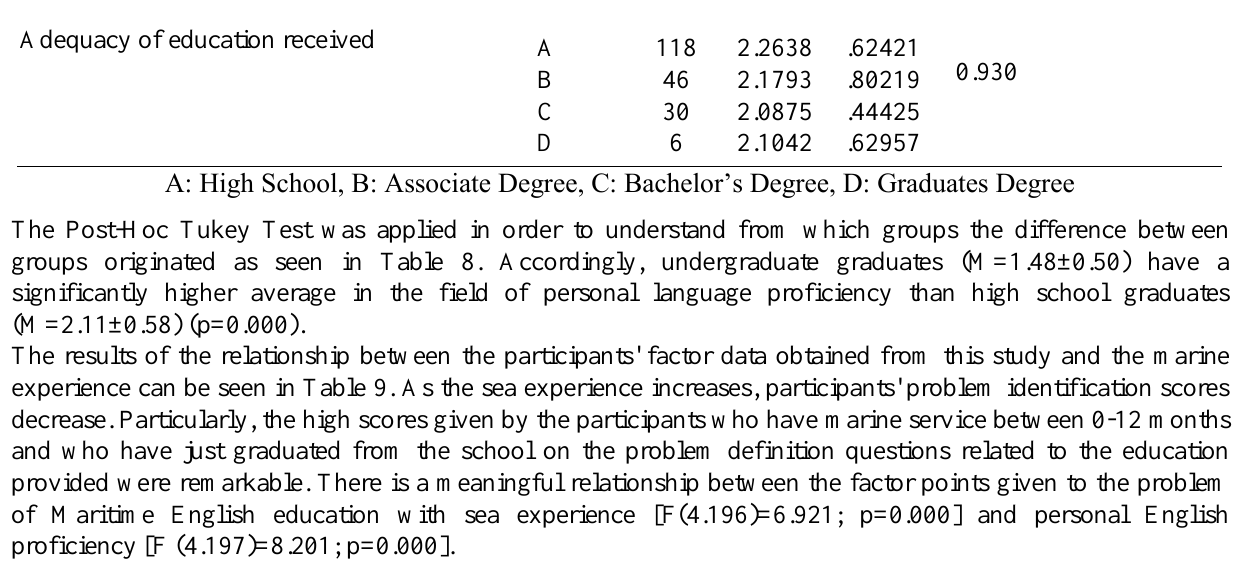
Table 9. The distribution of the average scores of the participants on Maritime